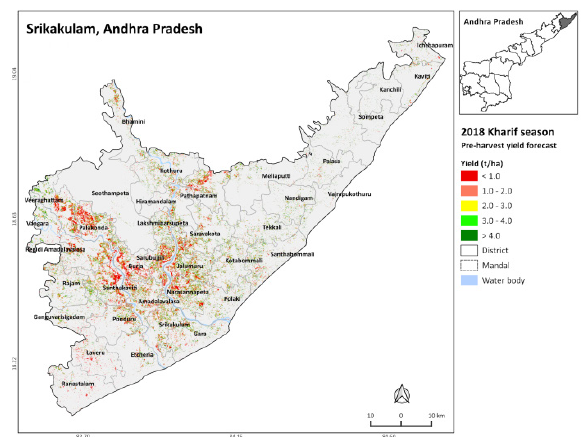
Figure 5. Pre-harvest yield forecast in Srikakulam district, 2018 kharif , 3 October 2018.